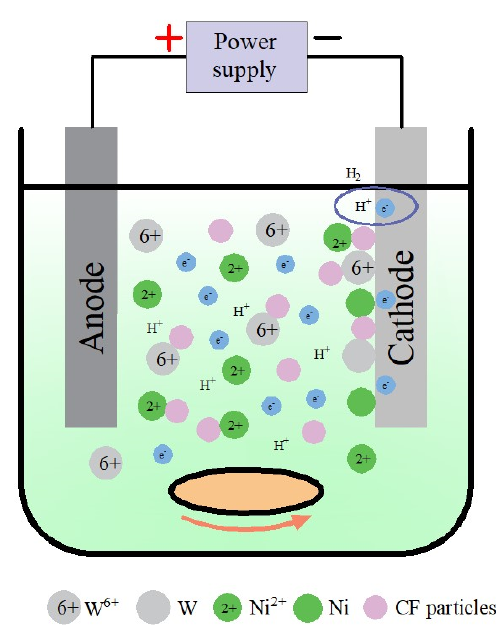
Figure 8. Distribution of ions in Ni-W-CF plating solution.